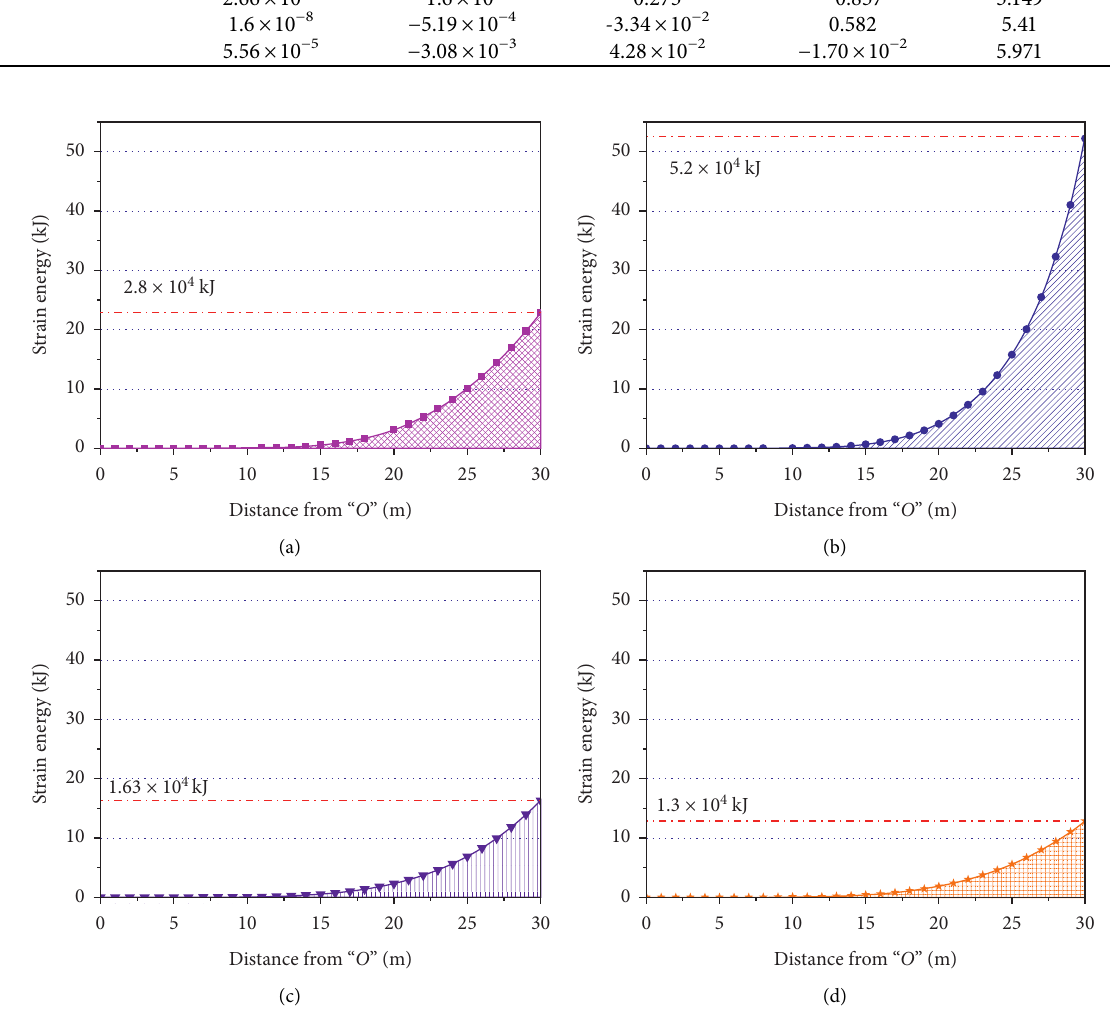
Figure 14: Elastic strain energy curve of key rock mass B .(a) 30 m. (b) 50 m. (c) 70m. (d)